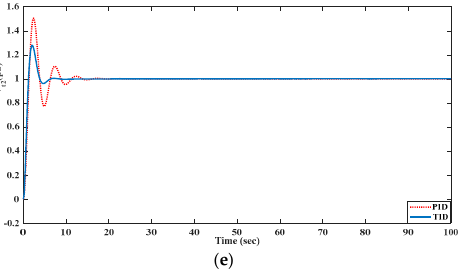
Figure 22. System dynamics for the combined AGC and AVR system with non-linearities and time delays (0.2 s) against RLP. ( a ) Δ f 1 ; ( b ) Δ f 2 ; ( c ) Δ P tie ; ( d ) V t1 ; ( e ) V t2 . Table 19. PID parameters for the combined AGC and AVR system with RLD, all non-linearities, and a 0.2 s delay. Parameter K P